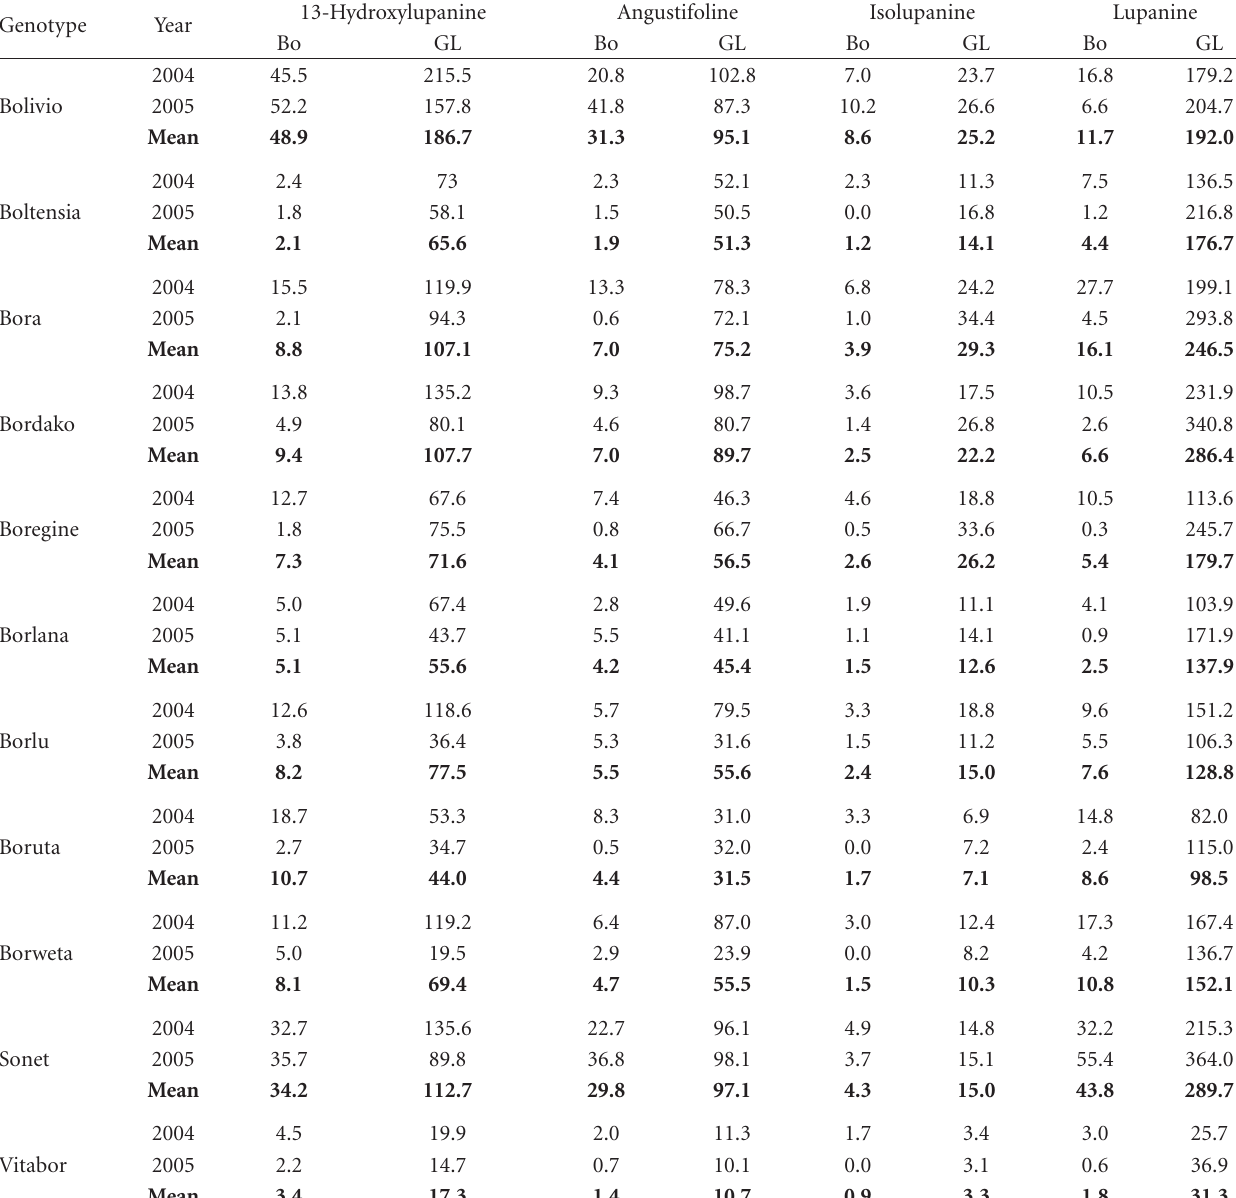
Table 2: Content of alkaloids in di ff erent cultivars of Lupinus angustifolius at di ff erent locations (2004 and 2005).